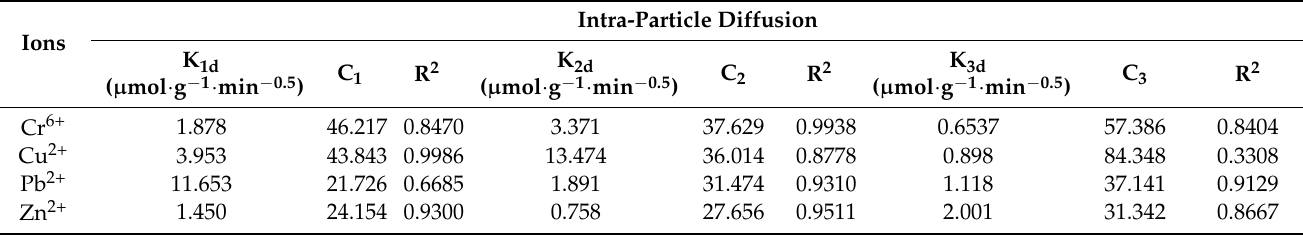
Table 2. Fitted parameter values of intraparticle diffusion kinetic